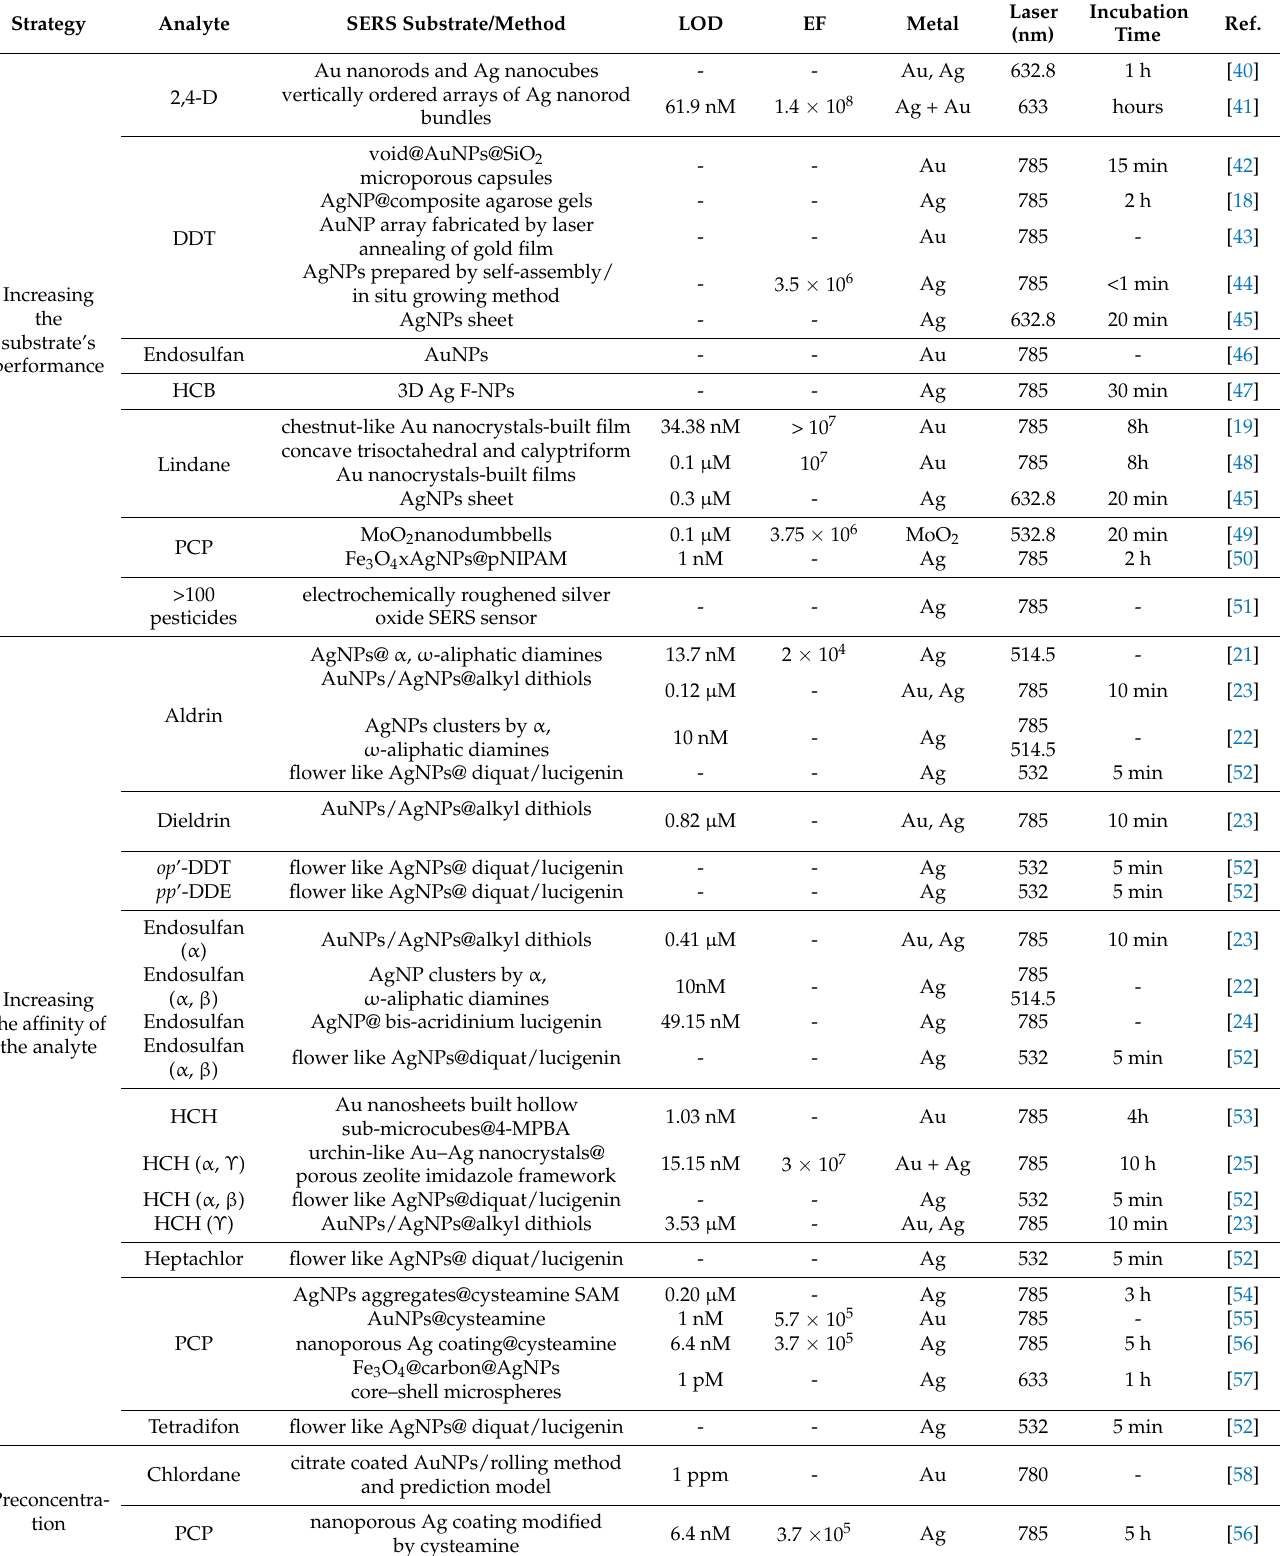
Table 1. Surface enhanced Raman spectroscopy (SERS) strategies for Organochlorine pesticide (OCP) detection.